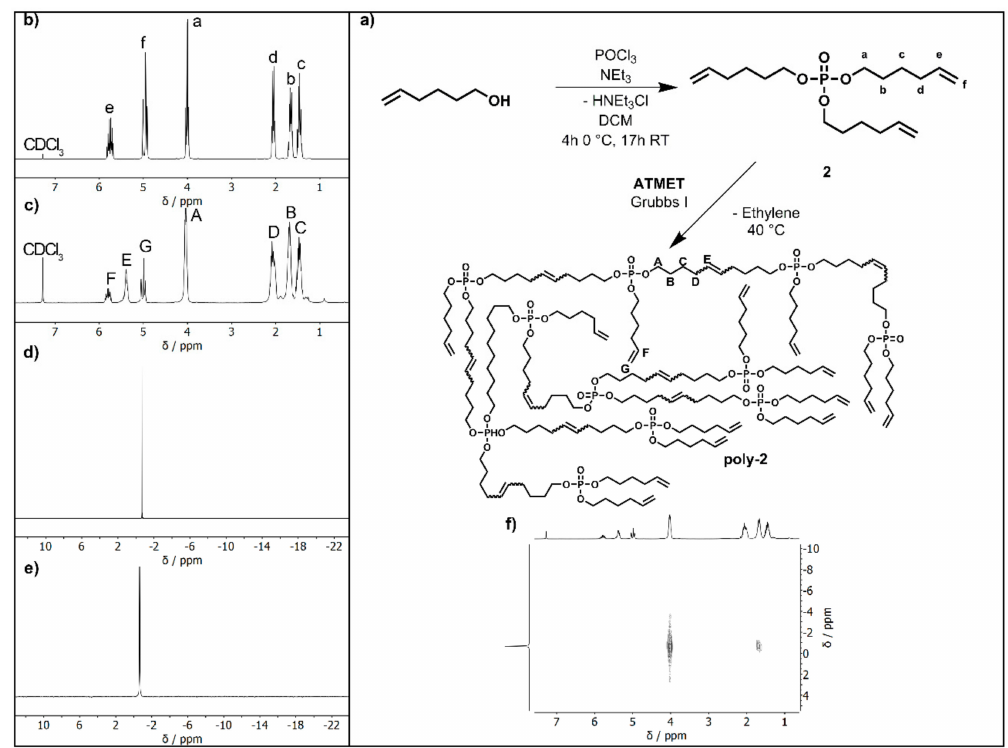
Figure 2. ( a ) Synthesis scheme of tri(hex-5-en-1-yl)phosphate (2) and poly(tri(hex-5-en-1-yl)phosphate) (poly-2); ( b ) 1 H NMR spectra of 2; ( c ) 1 H NMR spectra of poly-2; ( d ) 31 P NMR spectra of 2; ( e ) 31 P NMR spectra of poly-2; ( f ) 1 H 31 P HMBC spectra of